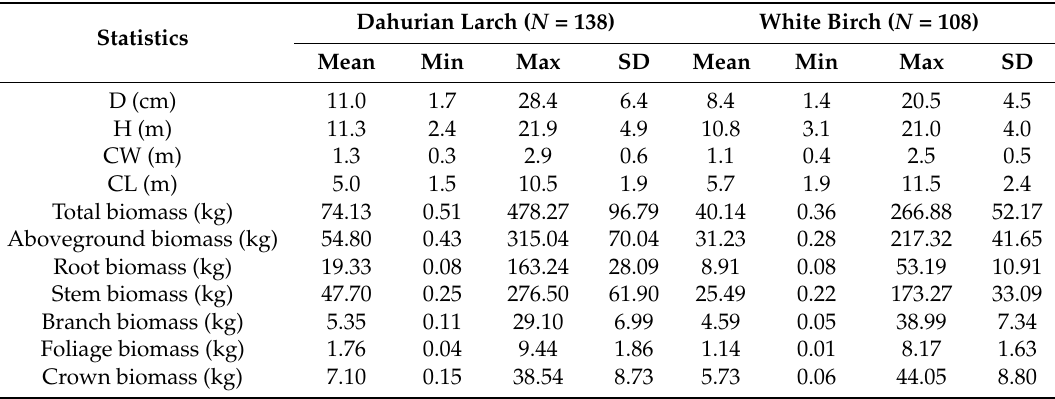
Table 2. Descriptive statistics of tree variables for the biomass data set of two tree species. CW = crown width; CL = crown